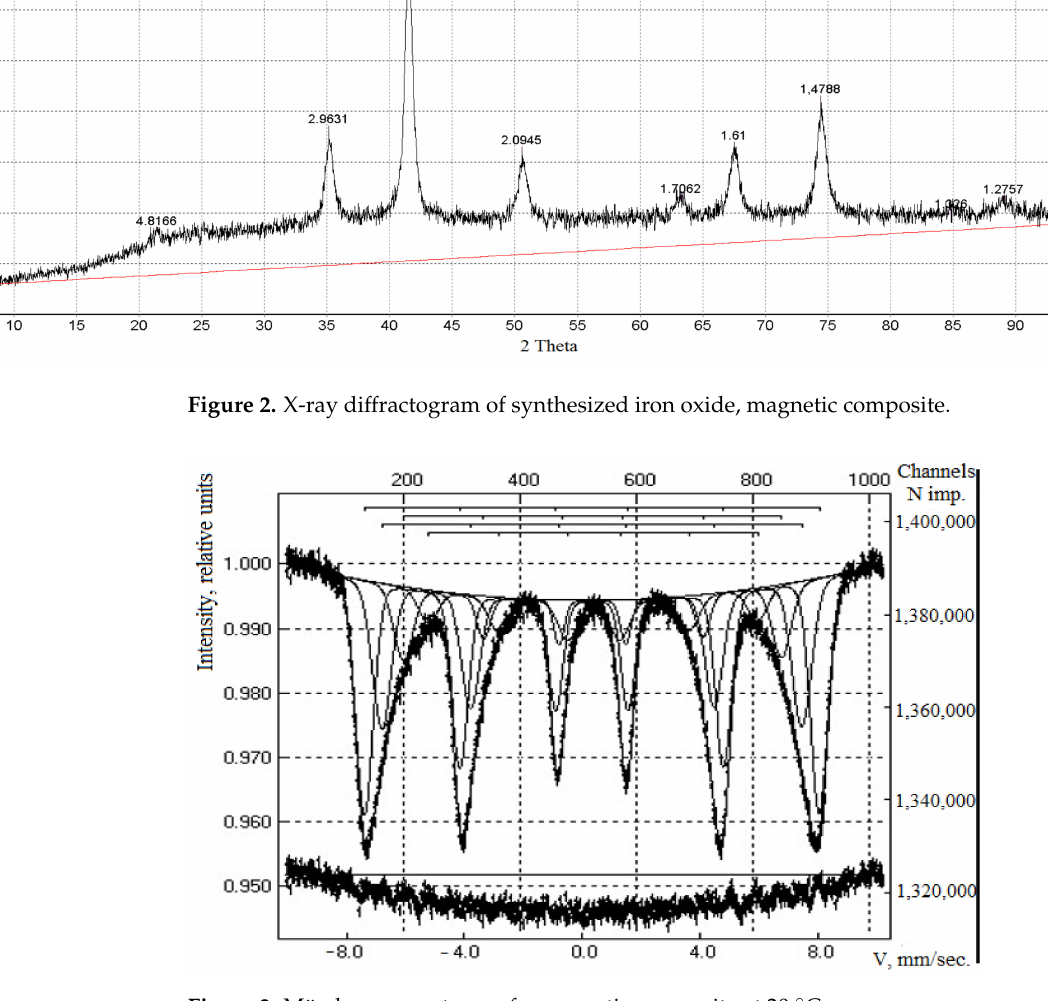
Figure 3. Mössbauer spectrum of a magnetic composite at 20 ◦